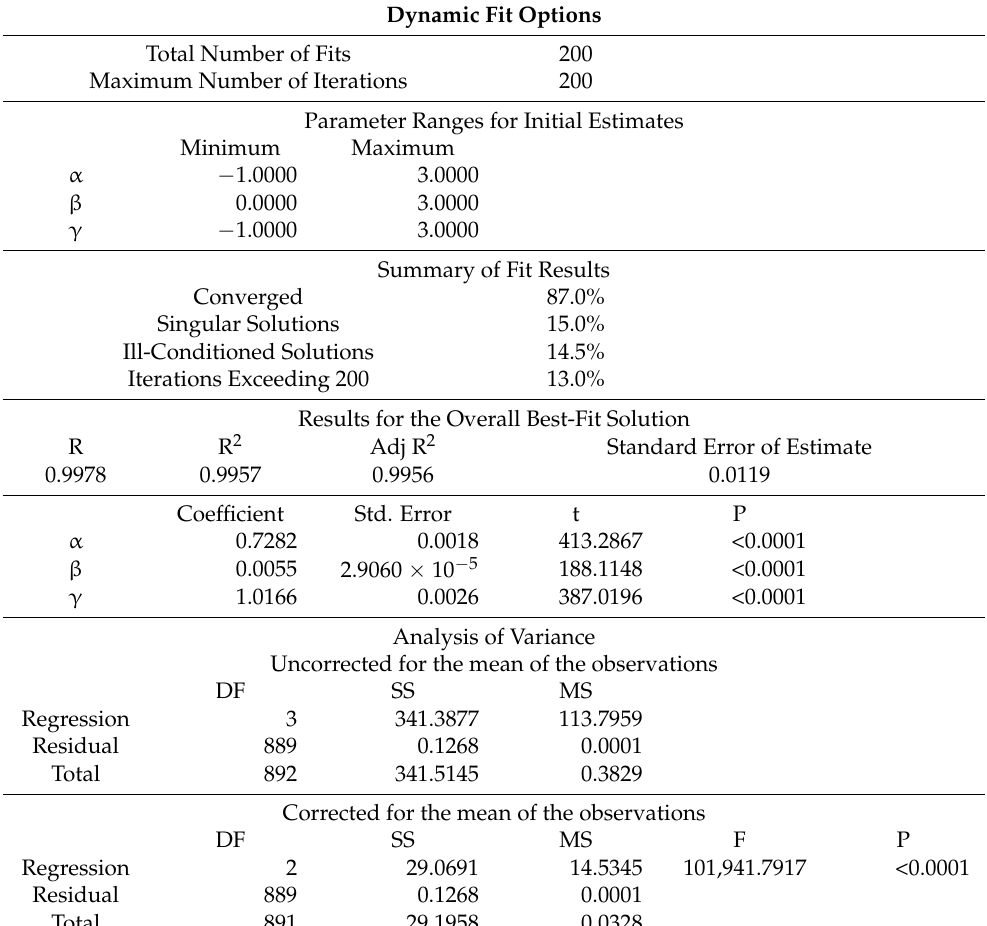
Table 1. Statistical output of the nonlinear regression (dynamic